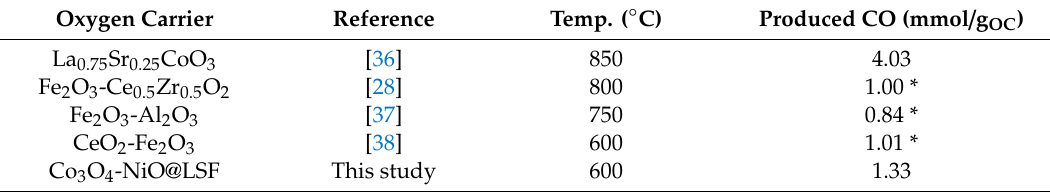
Figure 8. Cyclic performance of Co 3 O 4 @LSF during the long-term stability test. Table 3. Comparison for CO productions with various oxygen